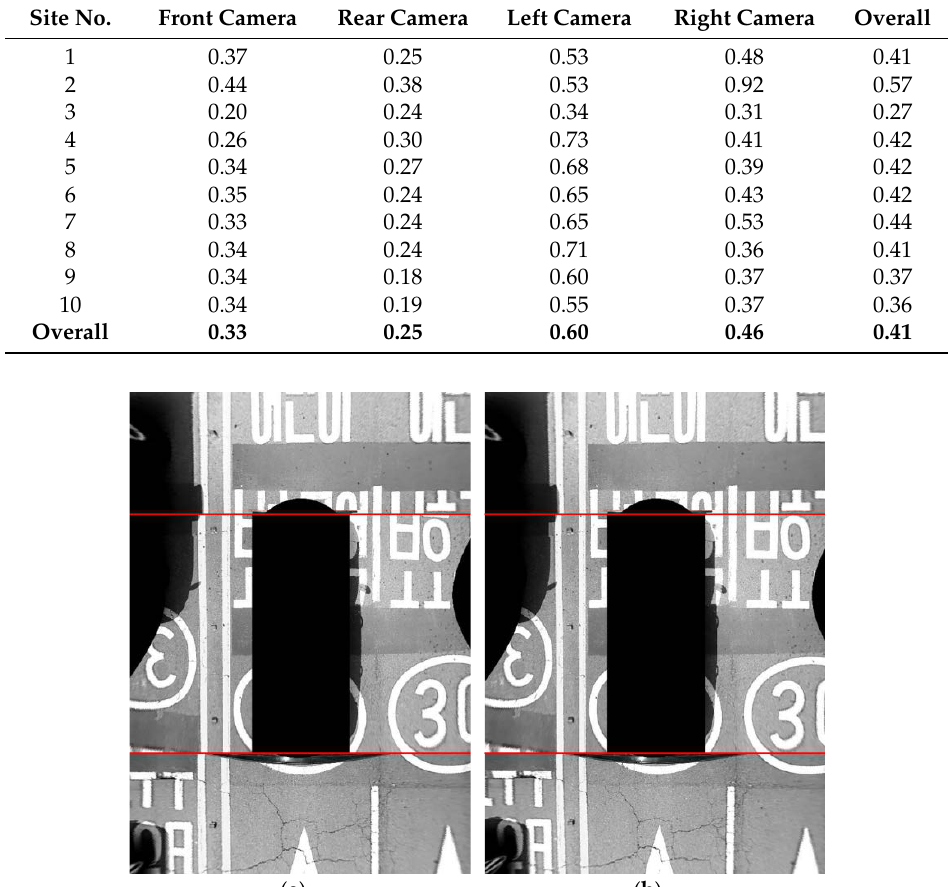
Table 2. Average Camera Angle Error with Parameter Co-Refinement (Degree).